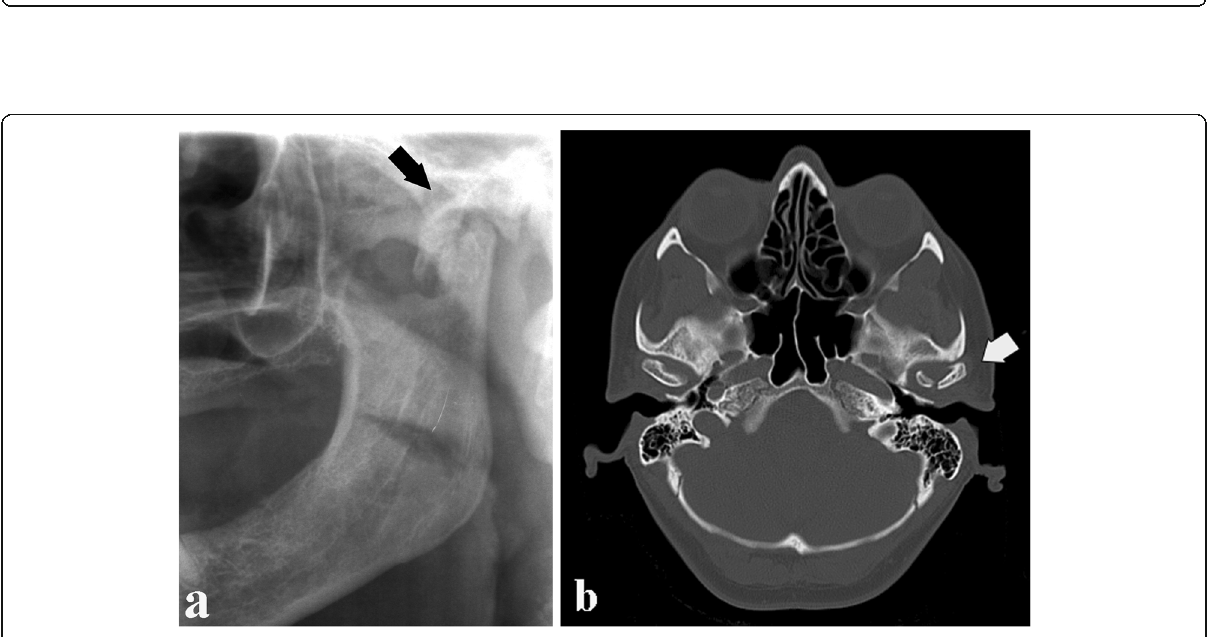
Fig. 19 Fracture of the glenoid fossa of the temporal bone. a Cropped panoramic radiograph shows a reduction of the articular space. The condylar head seems to be higher than its usual location (arrow). b , c Computed tomography coronal and sagittal sections. A slight upward movement of the mandibular condyle associated with a glenoid fossa fracture of the temporal bone is observed (arrows)